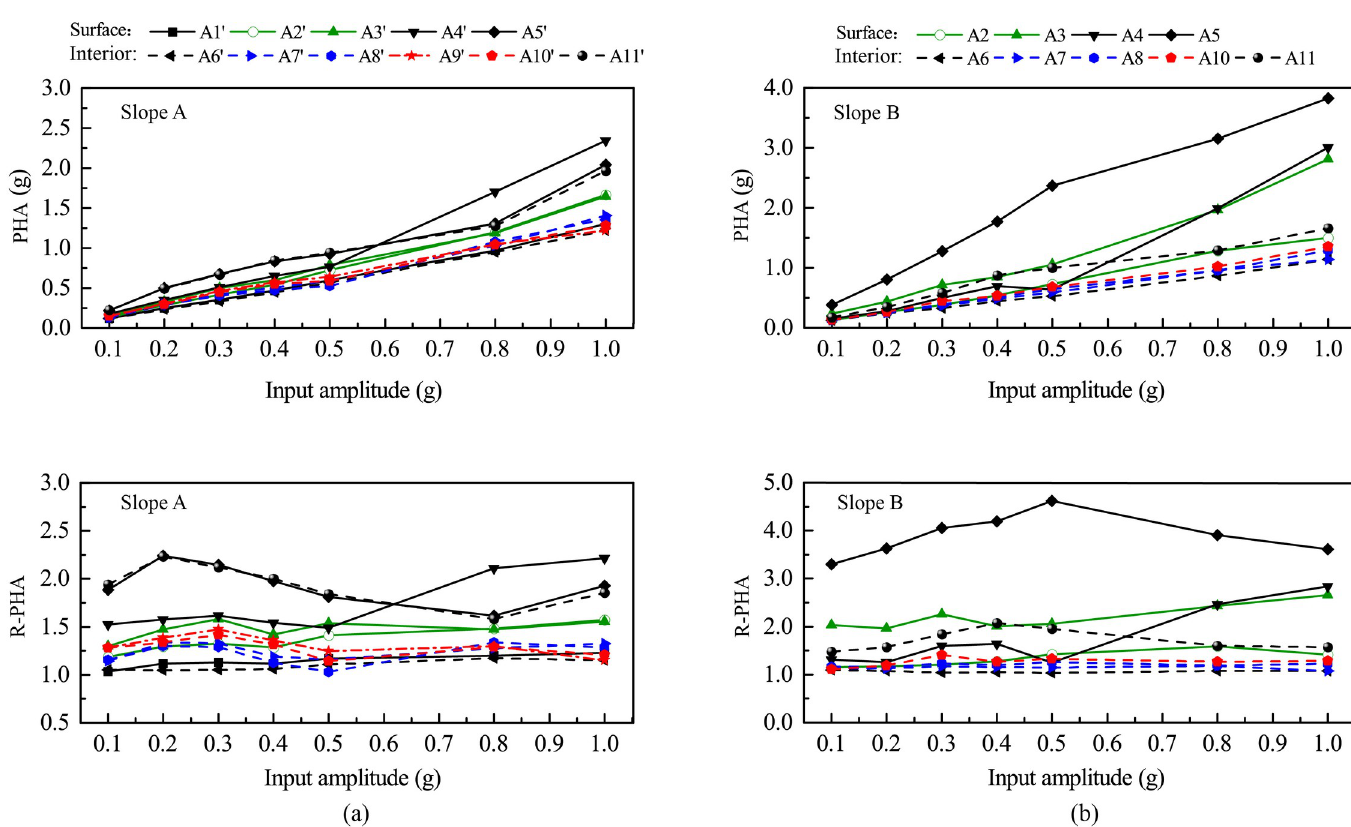
Fig 7. Peak horizontal acceleration (PHA) and corresponding amplification factor (R-PHA) of all monitoring points vs. amplitude of horizontal input acceleration: (a) Slope A; (b) Slope B.